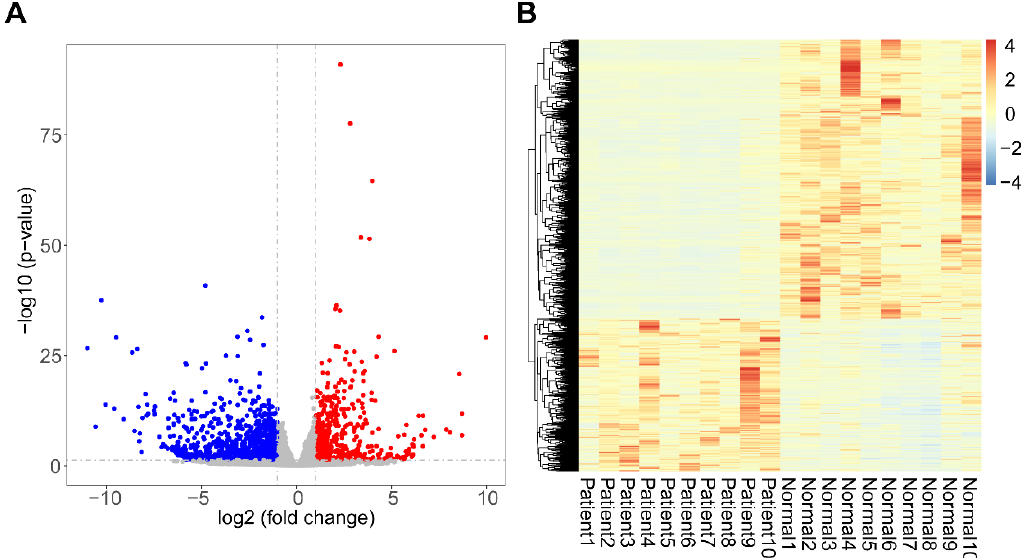
Figure 2. Identification of differentially expressed genes (DEGs). ( A ) Volcano plot of DEGs; red indicates up-regulated genes; blue indicates down-regulated genes. ( B ) Heatmap showing the expression of DEGs.